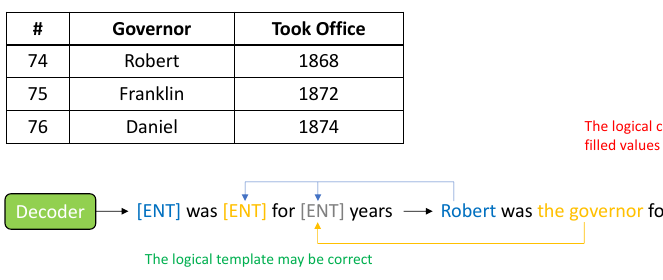
Figure 2. The coarse-to-fine generation scheme proposed by